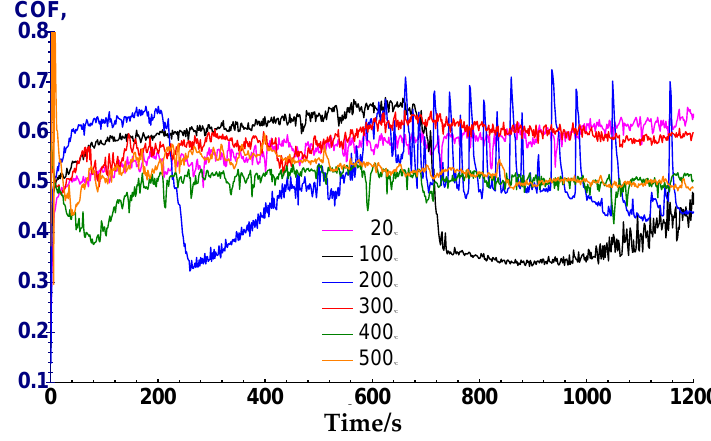
Figure 10. Friction coefficient curves of sample with ε = ~38%–42%, under different temperatures.